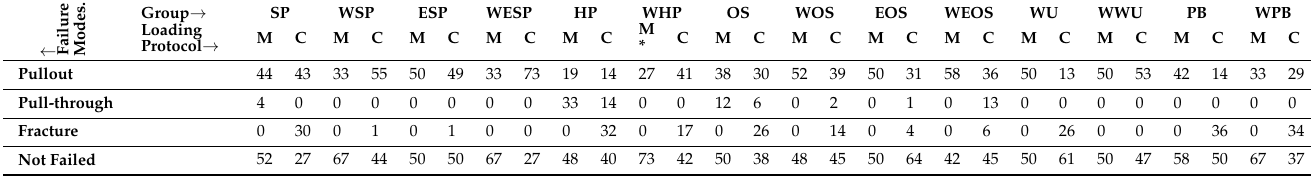
Figure 13. Specimen HP6 buckling under compression load (notice the sheathing damage). Table 5. Percentage (%) of connector failures by failure mode and